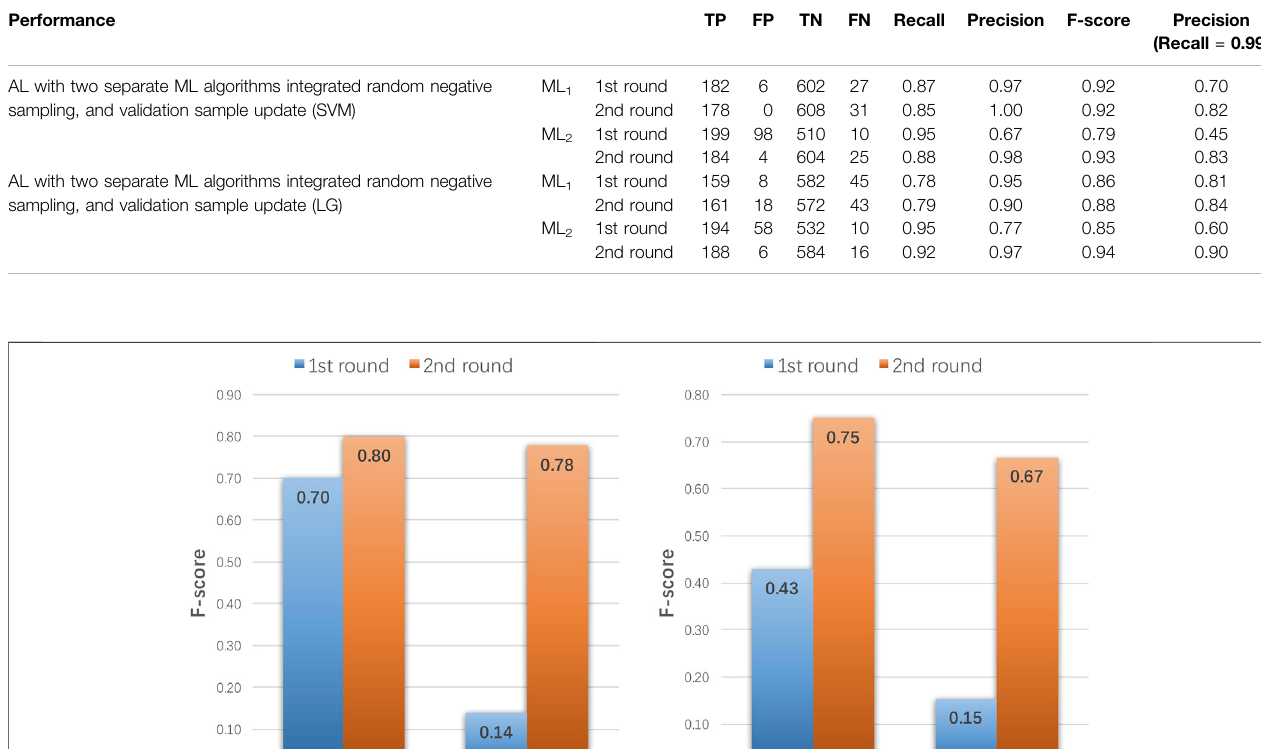
Frontiers in Pharmacology |